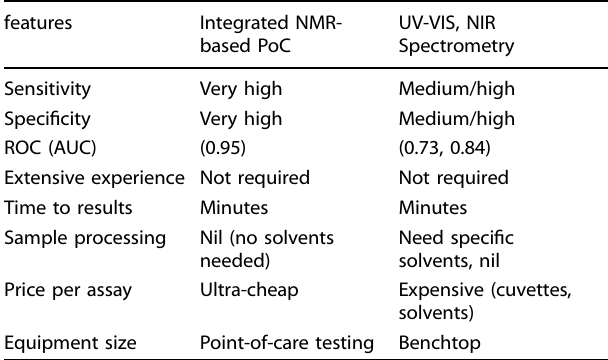
Table 3. Qualitative performance of the NMR-based PoC against conventional methods (UV-Vis, NIR).